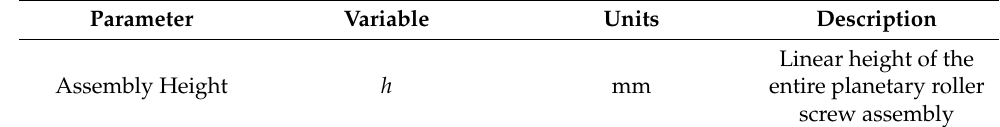
The number of rollers to place in the assembly. Limited by the diameter of the rollers. Need at least